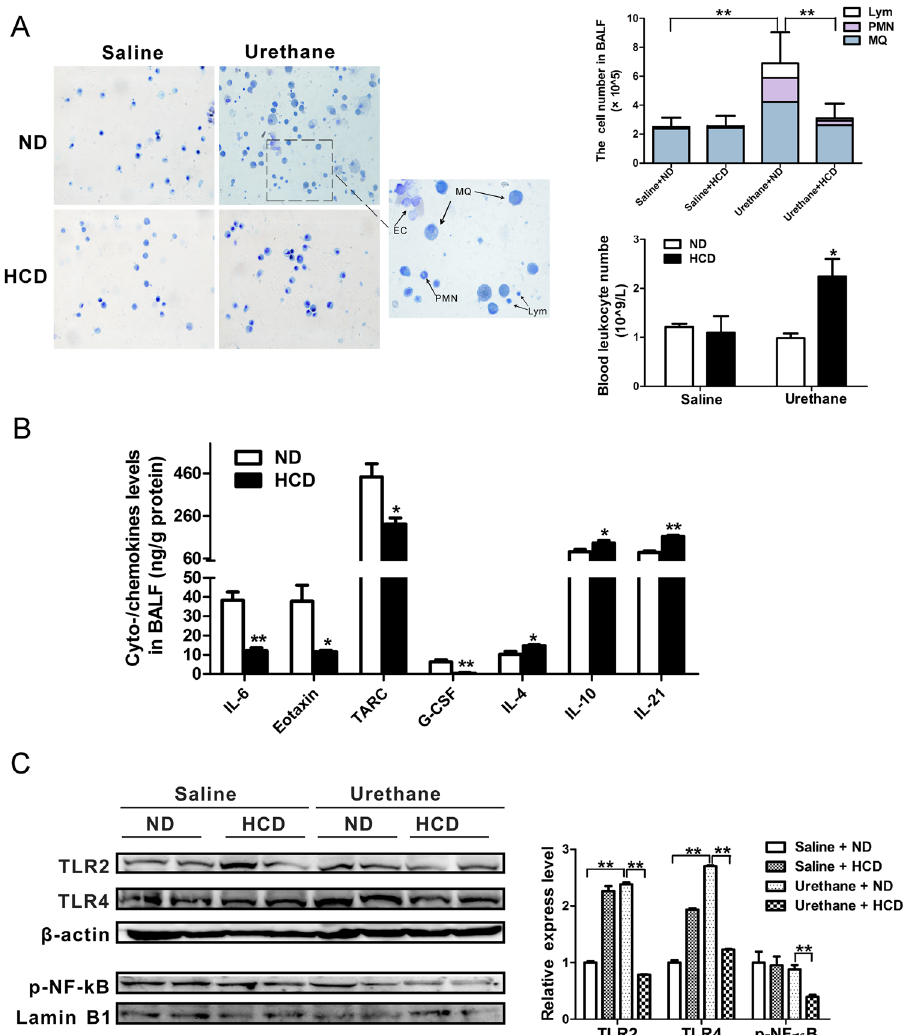
Figure 3. Attenuated lung inflammation and NF- κ B activation in urethane treated HCD-fed C57BL/6J mice compared to ND-fed mice. Studies were carried out at experimental week 13, right after the 10 times consecutive saline or urethane injections. ( A ) Diff-Quik staining of BALF cells (left), BALF inflammatory cell counting (upper right), and blood leukocyte counting (lower right). n = 3–5 mice per group. ( B ) Multiplex antibody array quantification of selective inflammatory cyto-/chemokines in the BALF of urethane treated HCD-fed or ND-fed C57BL/6J mice (n = 3 mice per group). Cyto-/chemokines levels in BALF were corrected for BALF protein concentration and presented as ng/g protein. ( C ) Western blotting for the expression of TLR2, TLR4 and phosphorylated NF- κ B p65 in the lungs. β -actin and Lamin B1 were used as the internal cytoplasma or nuclear protein control, respectively. Representative two mice results in each group and cropped gels/blots were displayed in the photos. Densitometry quantification was analyzed among 3 to 5 mice per group using Image J software. Columns, mean; bar, SEM. * P < 0.05; ** P < 0.01. BALF: bronchoalveolar lavage fluid; MQ: macrophages; PMN: polymorphonucleated cells; EC: epithelial cells; Lym: